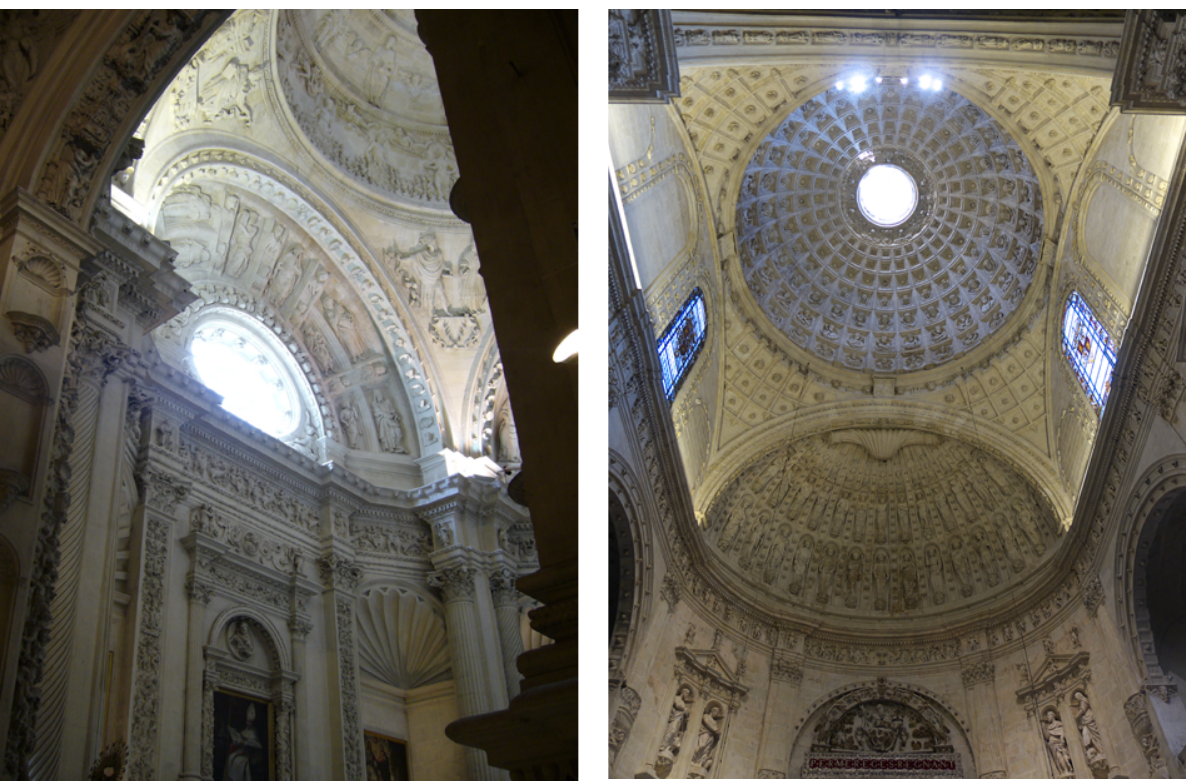
Figure 4: Interior of the Royal Chapel, Seville Cathedral. Image